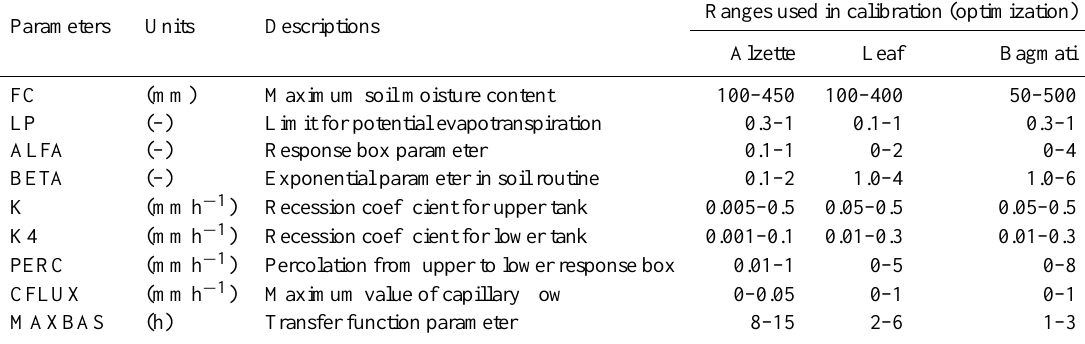
Table 2. The ranges of model